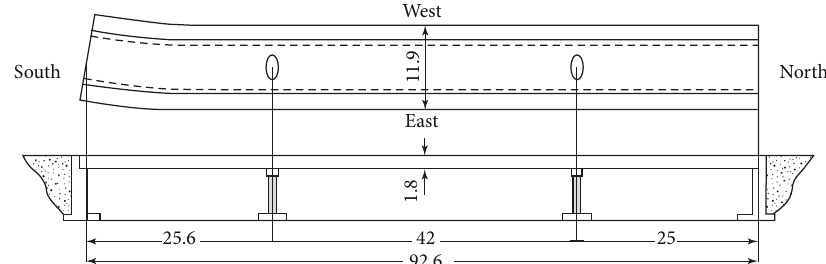
Figure 2: Technical drawing with the main geometrical features of the Magaz bridge (units in meter).